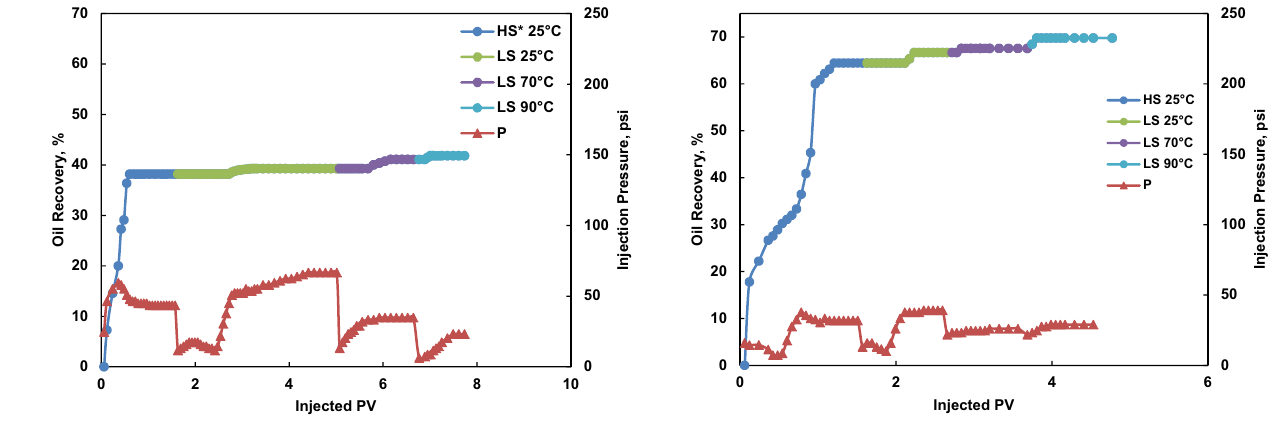
Fig. 8 Oil recovery factor and pressure profile for core#4, which was sequentially flooded by HS water–LS water at 25, 70, and 90 °C